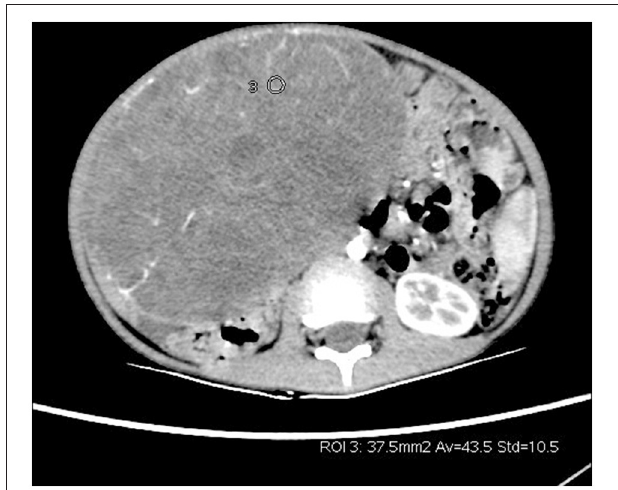
FIGURE 1 | Enhanced CT of the arterial phase of a giant solid-cystic lesion in the right lower abdomen with abundant tumor vascularity.